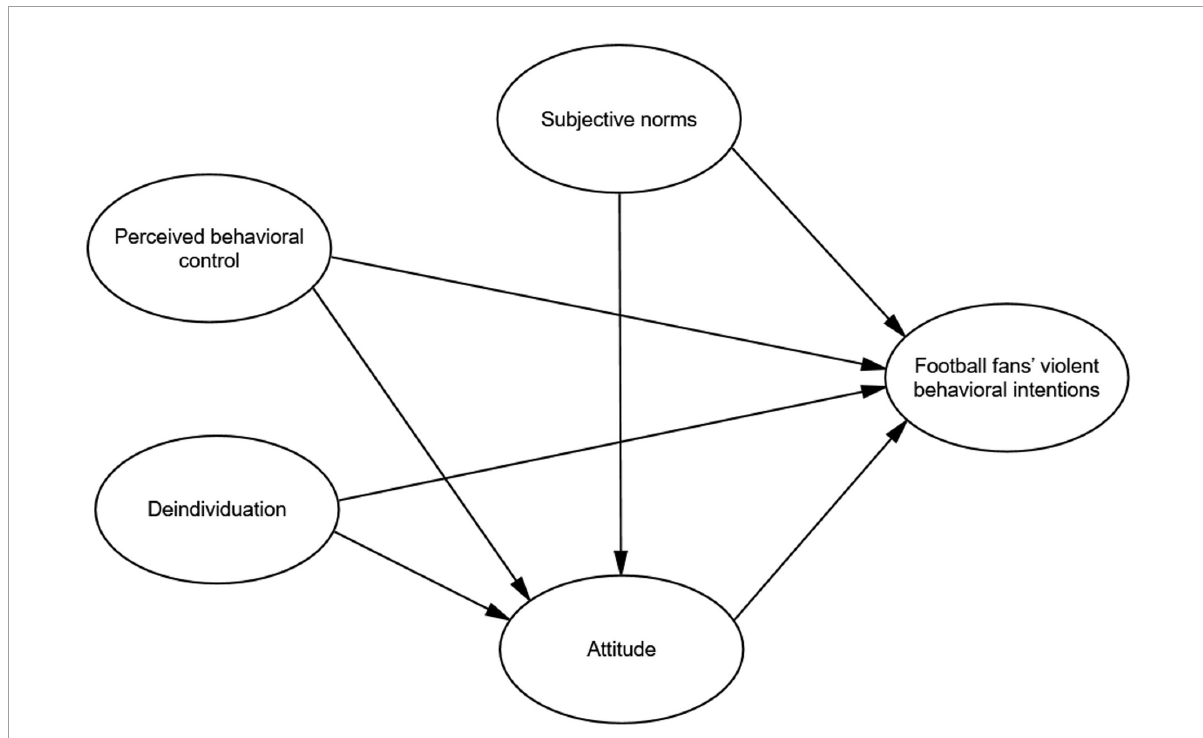
FIGURE1 The hypothesis